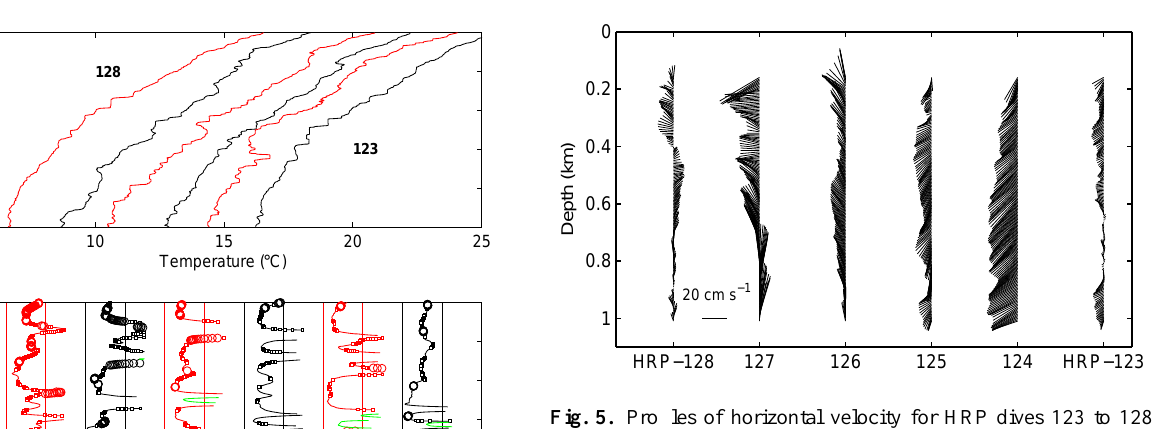
Fig. 5. Profiles of horizontal velocity for HRP dives 123 to 128 shown between 160–1010m. Velocity vectors from 15-m smoothed profiles are shown at every 5m (i.e., every 10th data point of 0.5m vertically sampled profiles).